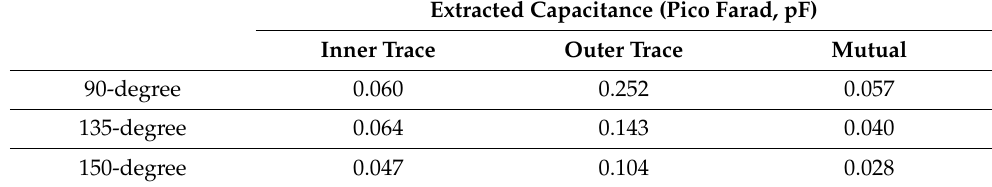
Table 1. Equivalent capacitance values.